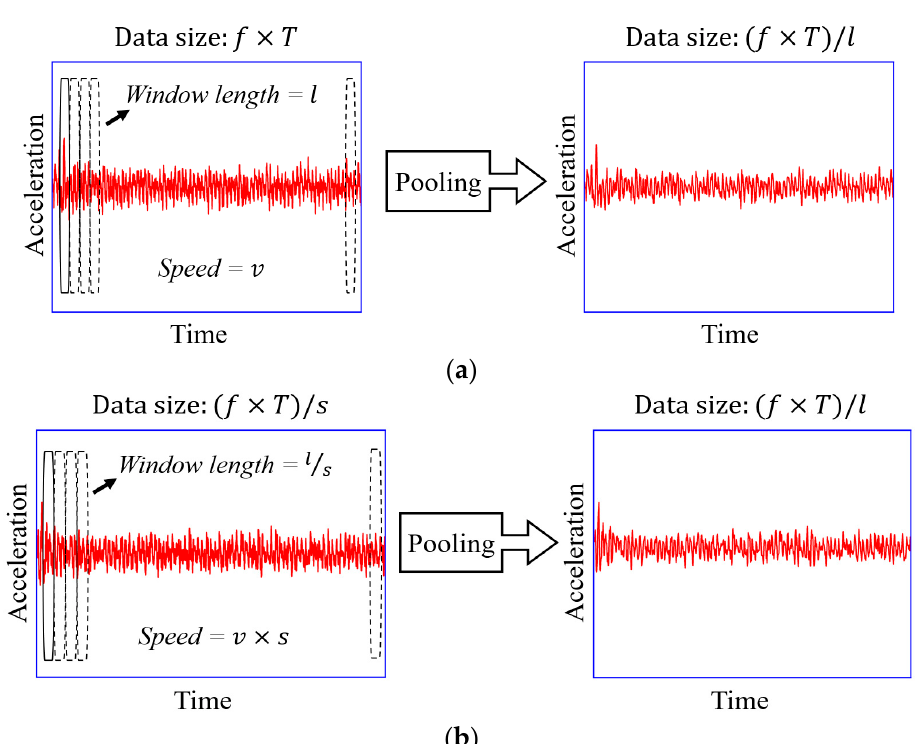
Figure 4. Pooling operation for vehicle’s time-domain signals with di ff erent speeds. ( a ) Speed = 𝑣 , ( b ) Speed = 𝑠 × 𝑣 .